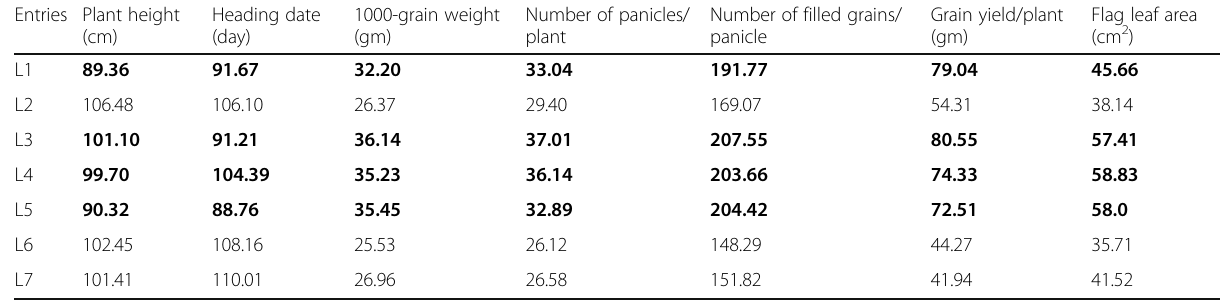
Table 11 The mean values obtained from the seven rice lines under all environments for all studied traits Entries Plant height Heading date (cm)